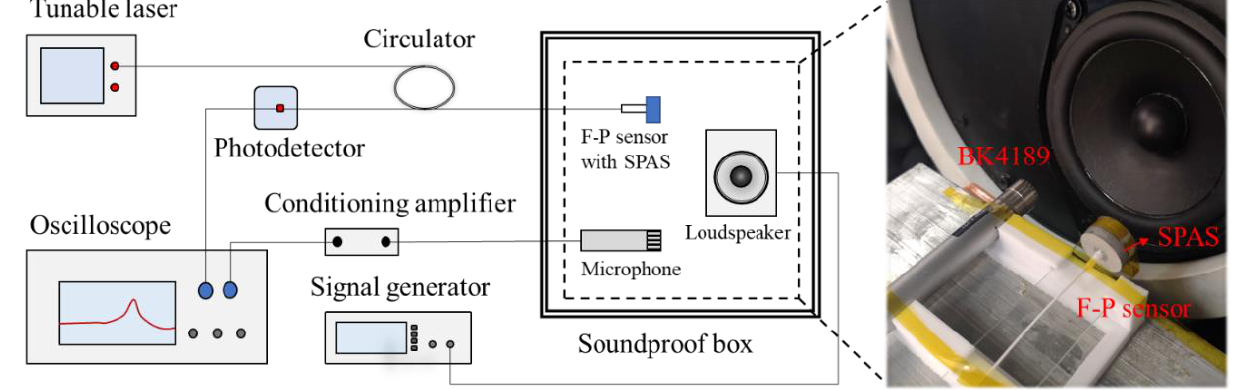
Figure 6. Experimental setup for the acoustic test.